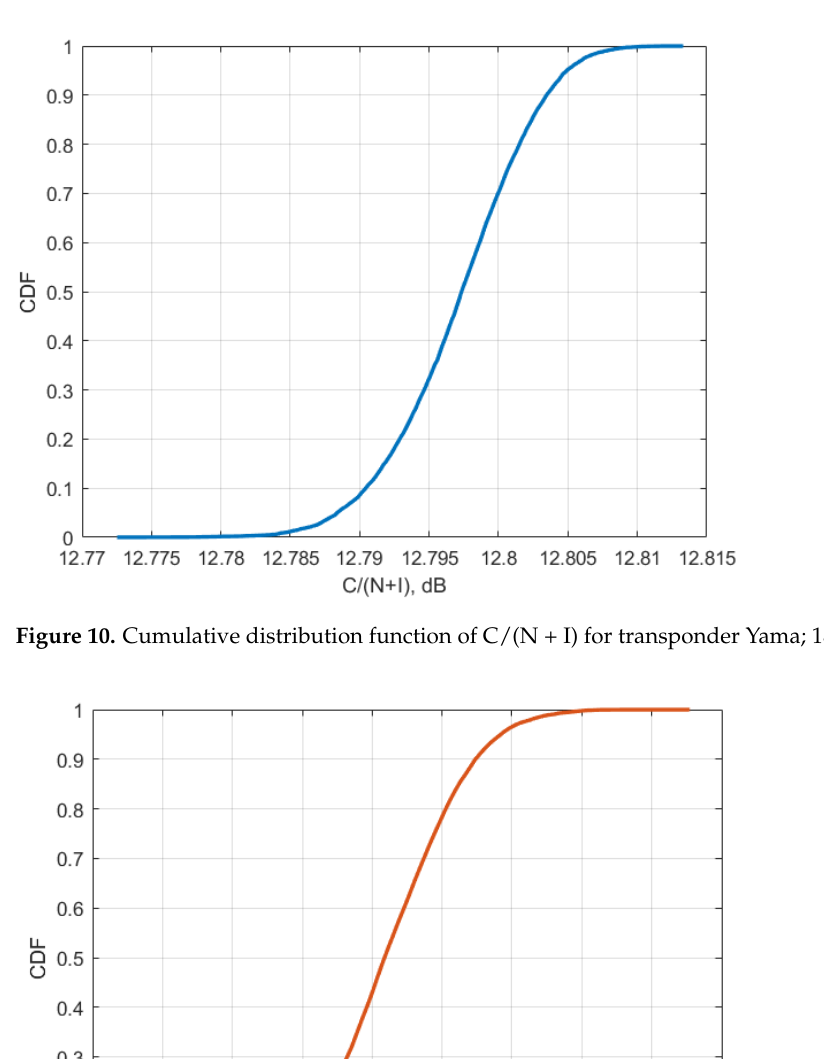
Figure 12. Cumulative distribution function of C/(N+I) for Yamal 90E for 6/4 GHz. Using values from Table 4 and CDF from Figures 10 – 12, for each of the satellite tran- sponder signal-to-noise degradation was calculated, and the results show that the level degradation is less than 0.1 dB. According to Recommendation ITU-R S.2131 [19], in DVB- S2 link with adaptive modulation and coding C/N reduction by 1 dB equals approx. 10% reduction of spectral efficiency. The obtained results show that in the case of 5G interfer- ence, the reduction of the spectral efficiency of satellite links will be very low. The results of signal-to-noise degradation of the considered bent pipe satellite transponders due to the interference from 5G base stations are presented as cumulative distribution functions of C/(N+I) in Figure 13.